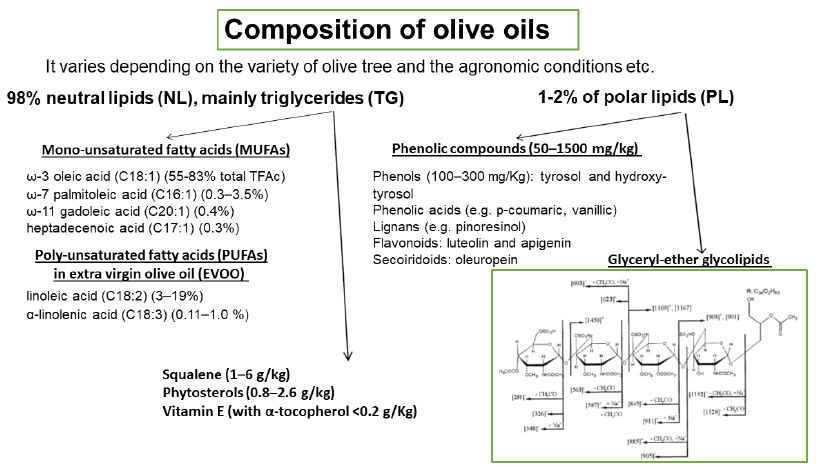
Figure 4. Composition of olive oils. Representative structure of olive oil glyceryl-ether